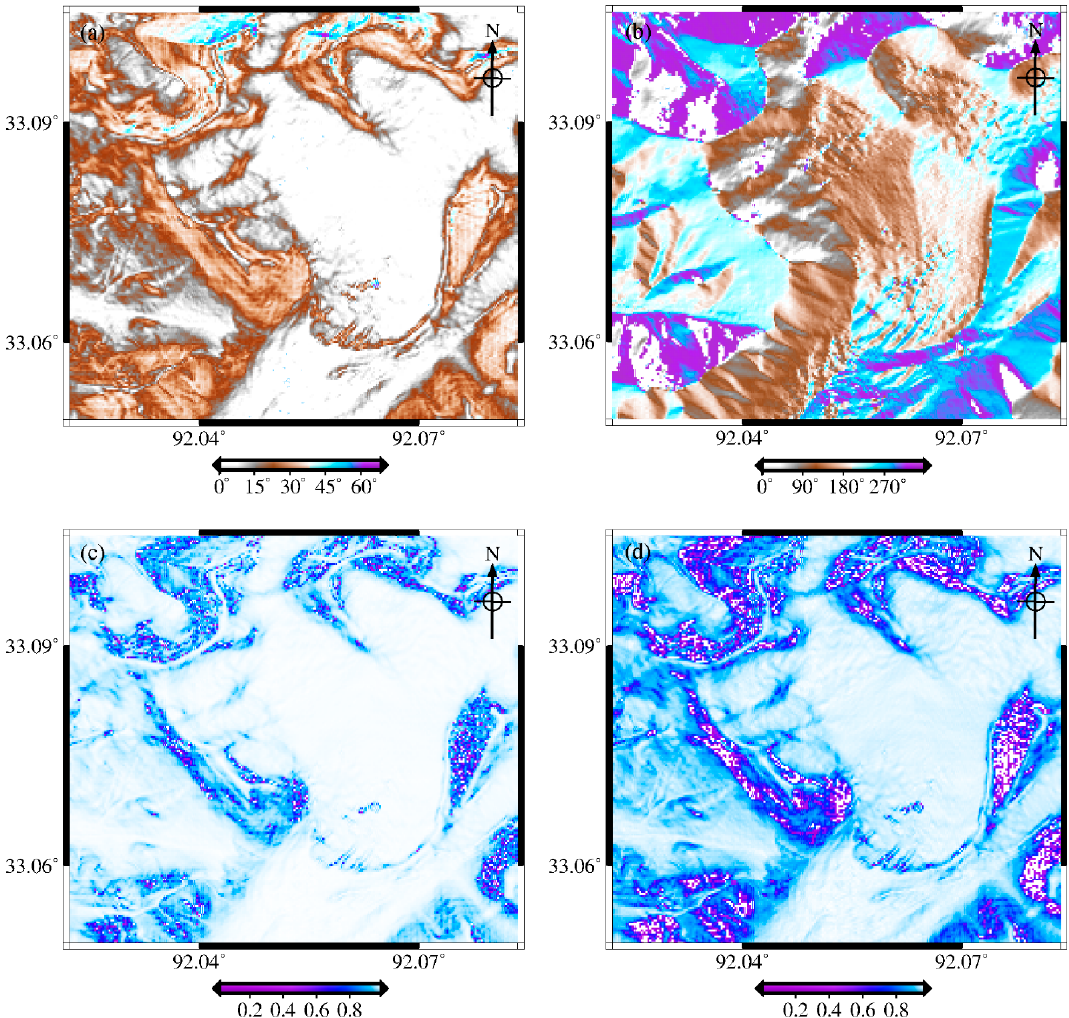
Figure 4. ( a , b ) show the slope- and orientation-angle map calculated from the Shuttle Radar Topography Mission (SRTM) Digital Elevation Model (DEM) data for the DDG study area, respectively. ( c , d ) show the spatial coherence map calculated using Equation (3) for the two spatial baseline cases, i.e., 𝐵 (cid:2884) =50 m and 200 m, respectively. Variations in surface backscattering were due to the change in surface parameters, e.g.,